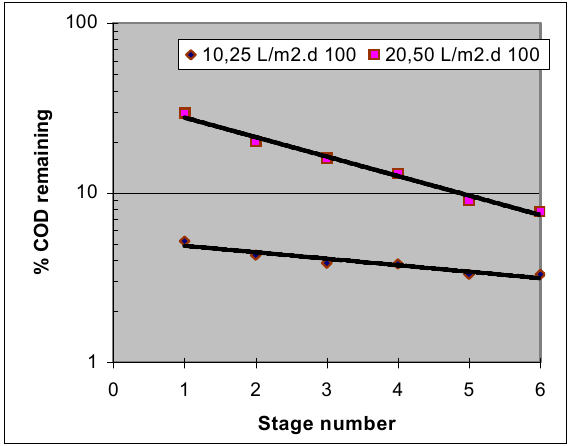
Figure 4: Percent COD remaining per stage for synthetic wastewater at constant concentration, and varying flow rates. [31]